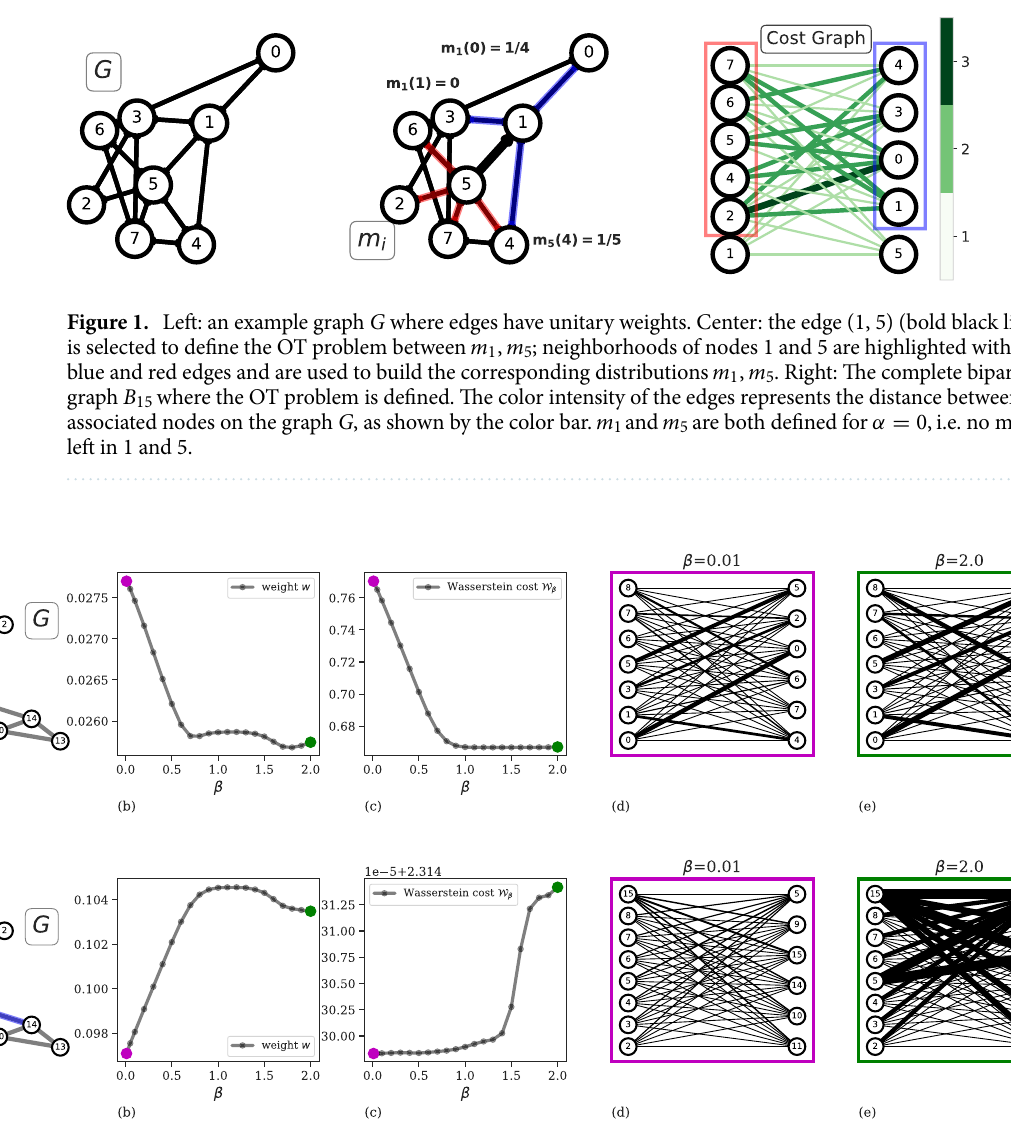
Figure 2. Visualization of how β impacts intra-community and inter-community edge weights. ( a ) Examples of intra-community (top panel) and inter-community (bottom panel) structures between nodes 6 and 7, and nodes 5 and 15, respectively. ( b ) The weight of edge (6, 7) decreases when 0 < β < 0.6 , while for 0.5 < β < 2.0 it reaches a minimum, and then slightly increases again. Similar but opposite pattern is observed for the edge (5, 15). ( c ) The β -Wasserstein cost: for intra-community edges, β > 1 consolidates traffic in the network as the Wasserstein cost stabilizes, making it minimum for the extreme value β = 2 , whereas it is maximized in the case of the inter-community edge. ( d , e ) Example cost graphs B 67 (top) and B 515 (bottom) with fluxes solution